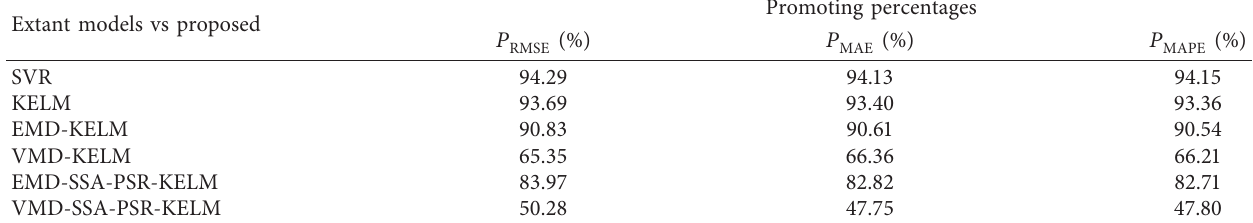
Table 5: Promotion percentage of the proposed model compared with the contrastive